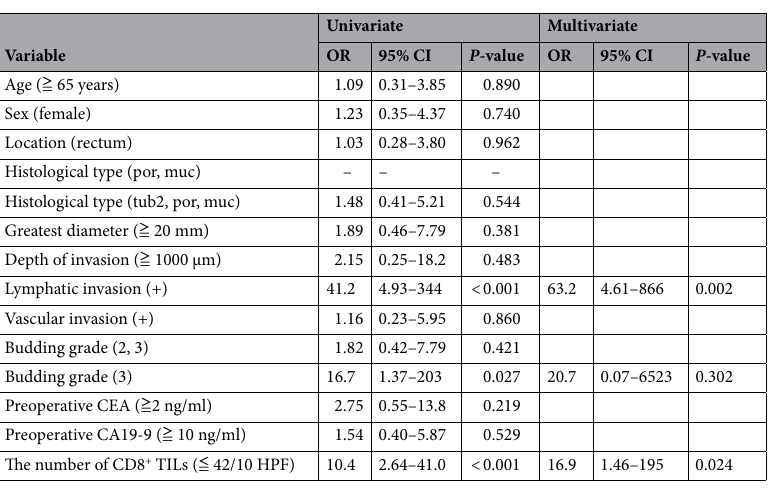
Table 2. Variables of lymph node metastasis (univariate and multivariate analyses). OR odds ratio, CI confidence interval, CEA carcinoembryonic antigen, CA19-9 Carbohydrate Antigen 19–9, CD cluster of differentiation, TIL tumor-infiltrating lymphocytes, HPF high-power